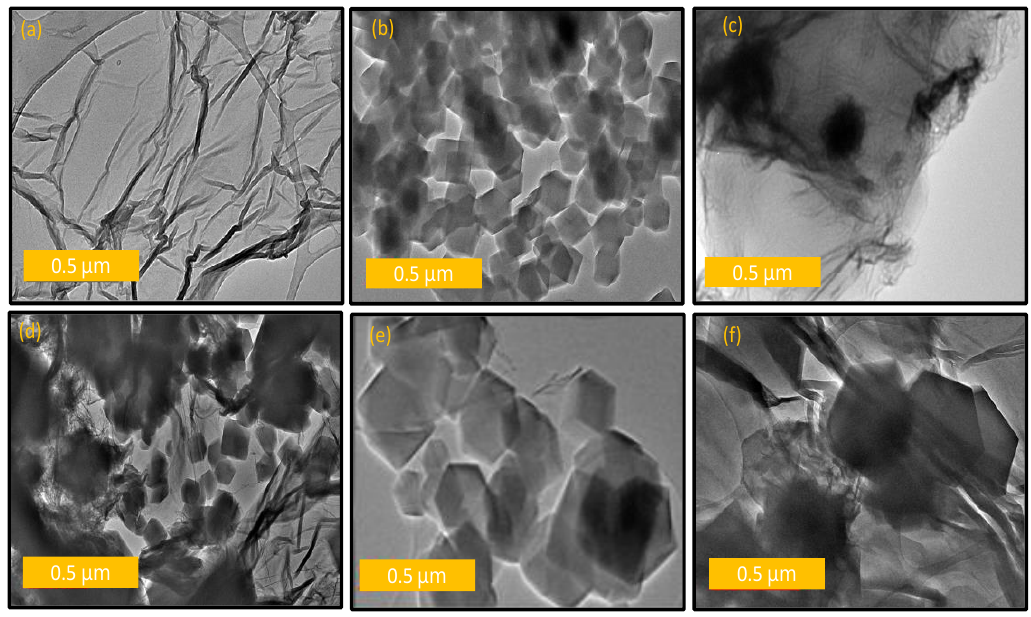
Figure 3. TEM images of ( a ) GO, ( b ) ZIF-8, ( c ) ZIF-8@GO 0.1:1, ( d ) ZIF-8@GO 0.5:1, ( e ) ZIF-8@GO 0.9:1, ( f ) ZIF-8@GO 1.0:1.